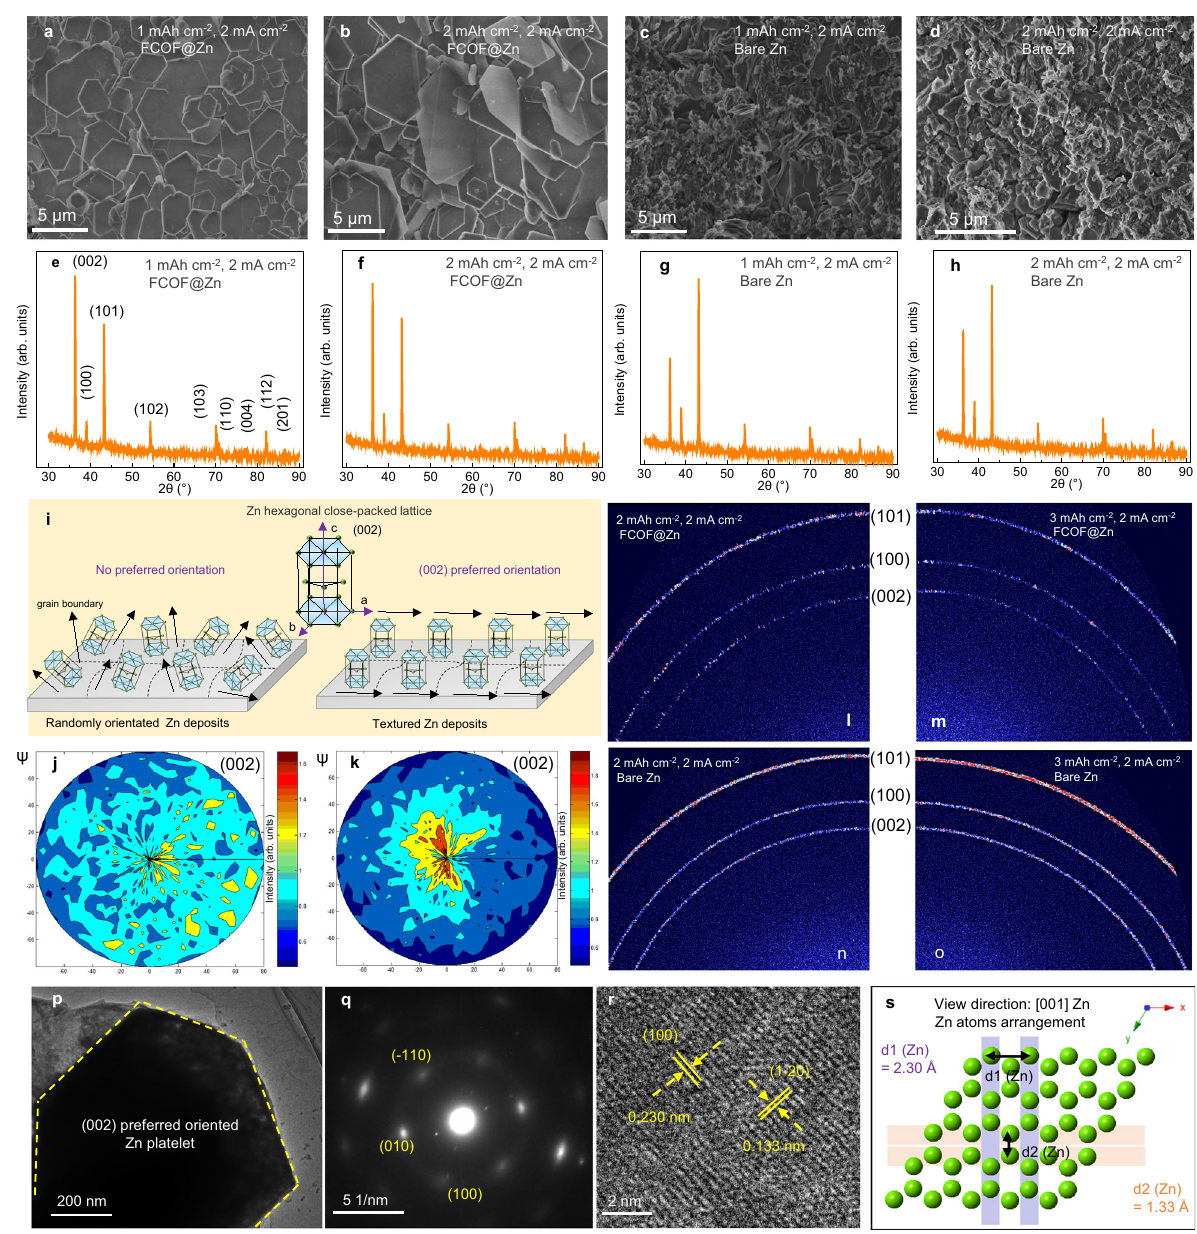
Fig. 3 Morphology, crystallography and microstructure characterization of Zn electrodeposits. FESEM images of Zn deposits a , b underneath a FCOF fi lm and c , d on bare Ti. XRD results for the Zn deposits e , f underneath the FCOF fi lm and g , h on bare Ti. i Schematic illustration of preferred orientations of Zn crystal plane. (002) plane pole fi gures of the Zn deposits j on bare Ti and k underneath FCOF fi lm. The WAXS results of Zn deposits l , m underneath FCOF fi lm and n , o on bare Ti. p – r HRTEM images and SAED patterns of the Zn platelet. s Theoretical atomic model of Zn along the [001]